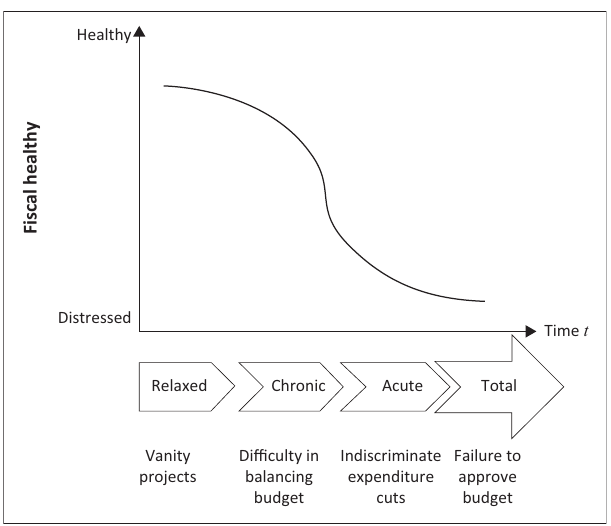
FIGURE 1: Stages of financial